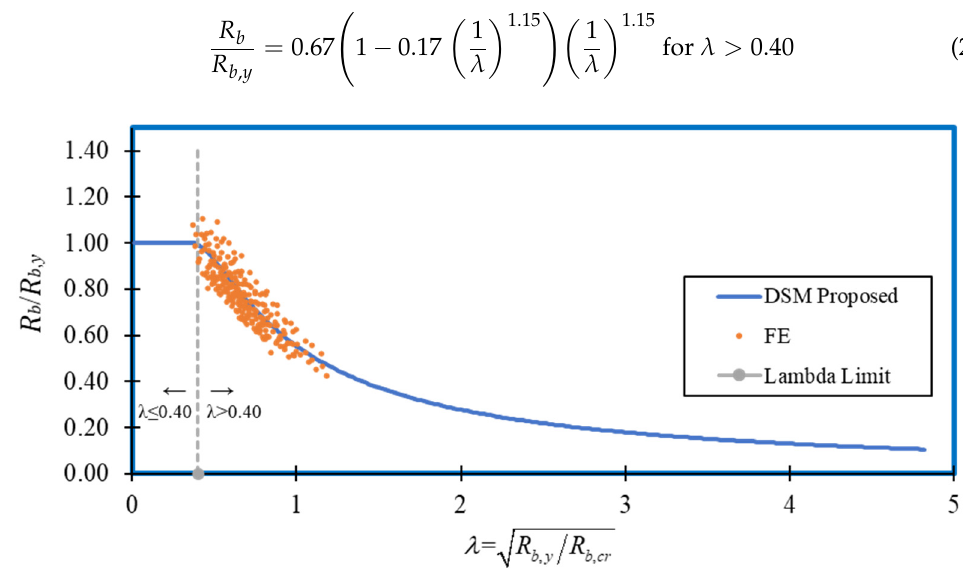
Figure 27. Comparison of parametric results and proposed DSM equation.